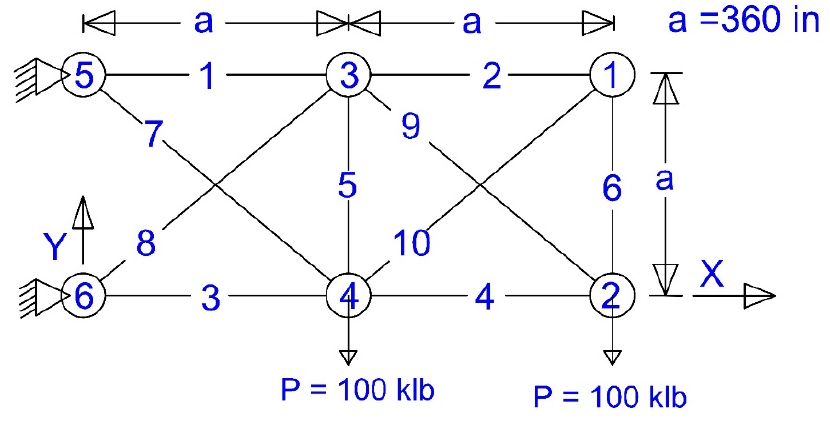
Figure 16. The 10-bar truss. Table 7. Design considerations of the truss